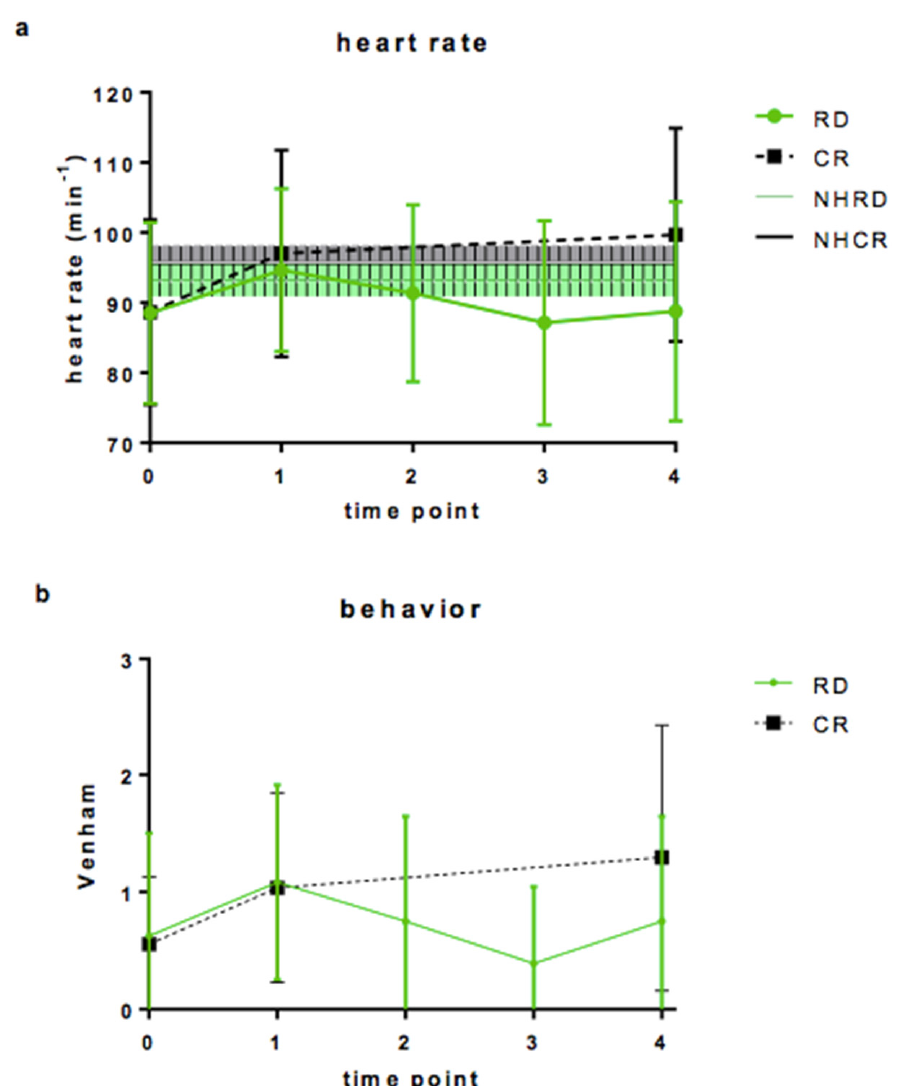
Figure 1. ( a ): Heart rate (min − 1 ) during the treatment with rubber dam (RD) or cotton-roll (CR) isolation. The shaded area represents the median and interquartile range of mean heart rate of the children (according to Fleming et al., 2011), (green RD, grey CR) at the different time points: T0: before intervention, T1 after local anesthesia, T2: before rubber dam placement, T3: after rubber dam placement, T4 during procedure. ( b ): Venham scale recorded at the same time points.